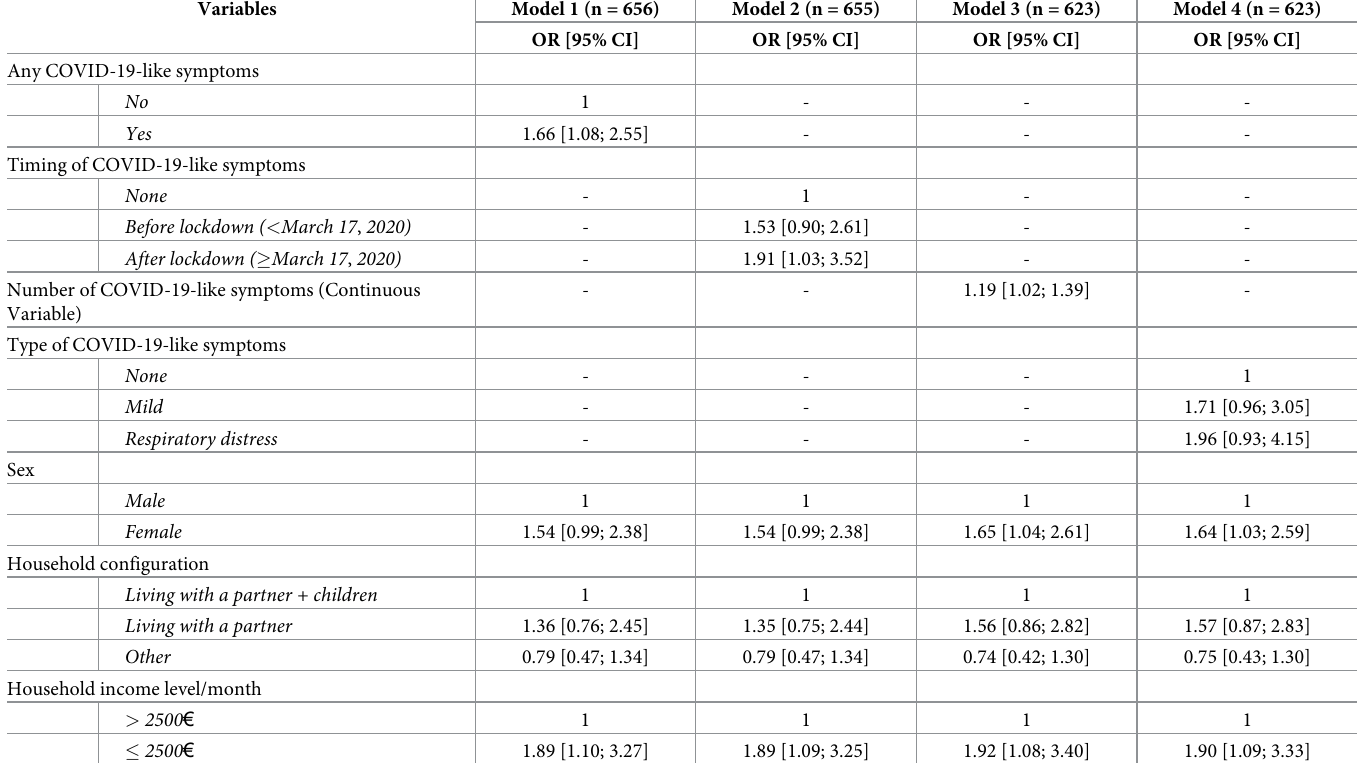
Table 3. COVID-19-like symptoms and anxiety/depression in the TEMPO cohort during the first COVID-19-related lockdown (March-June 2020, France, multi- variate GEE models, adjusted Odds-Ratio (OR), 95% Confidence Interval (CI)).